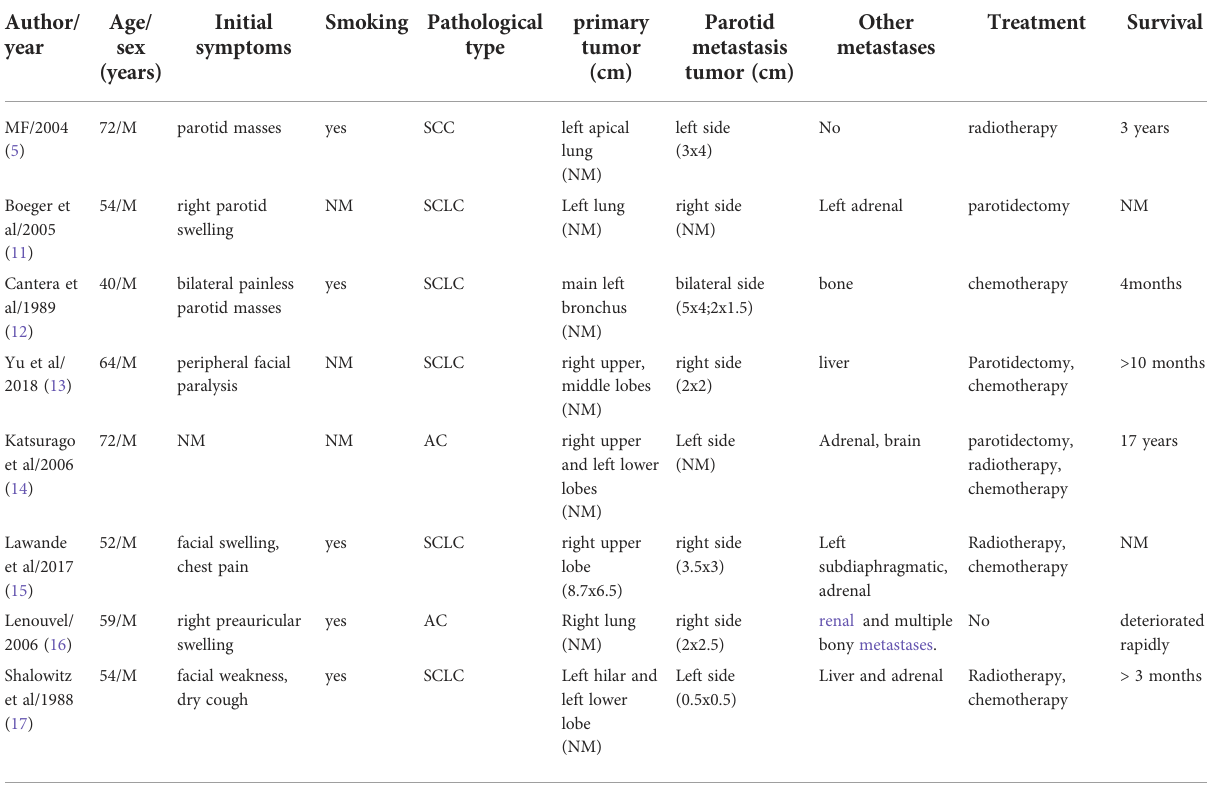
TABLE 1 the literature review of all cases of the parotid metastasis of the lung cancer.